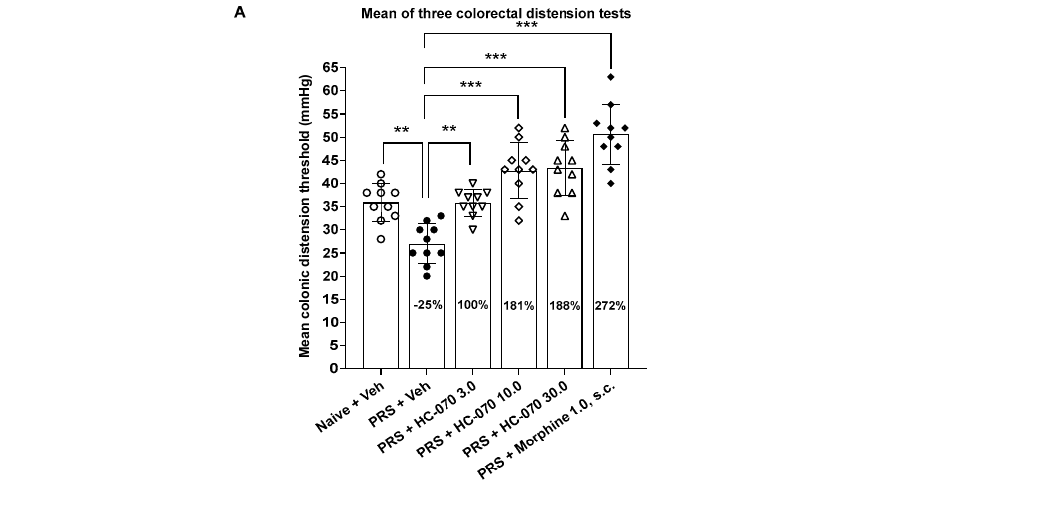
B Female rat PRS terminal tissue sampling PK.